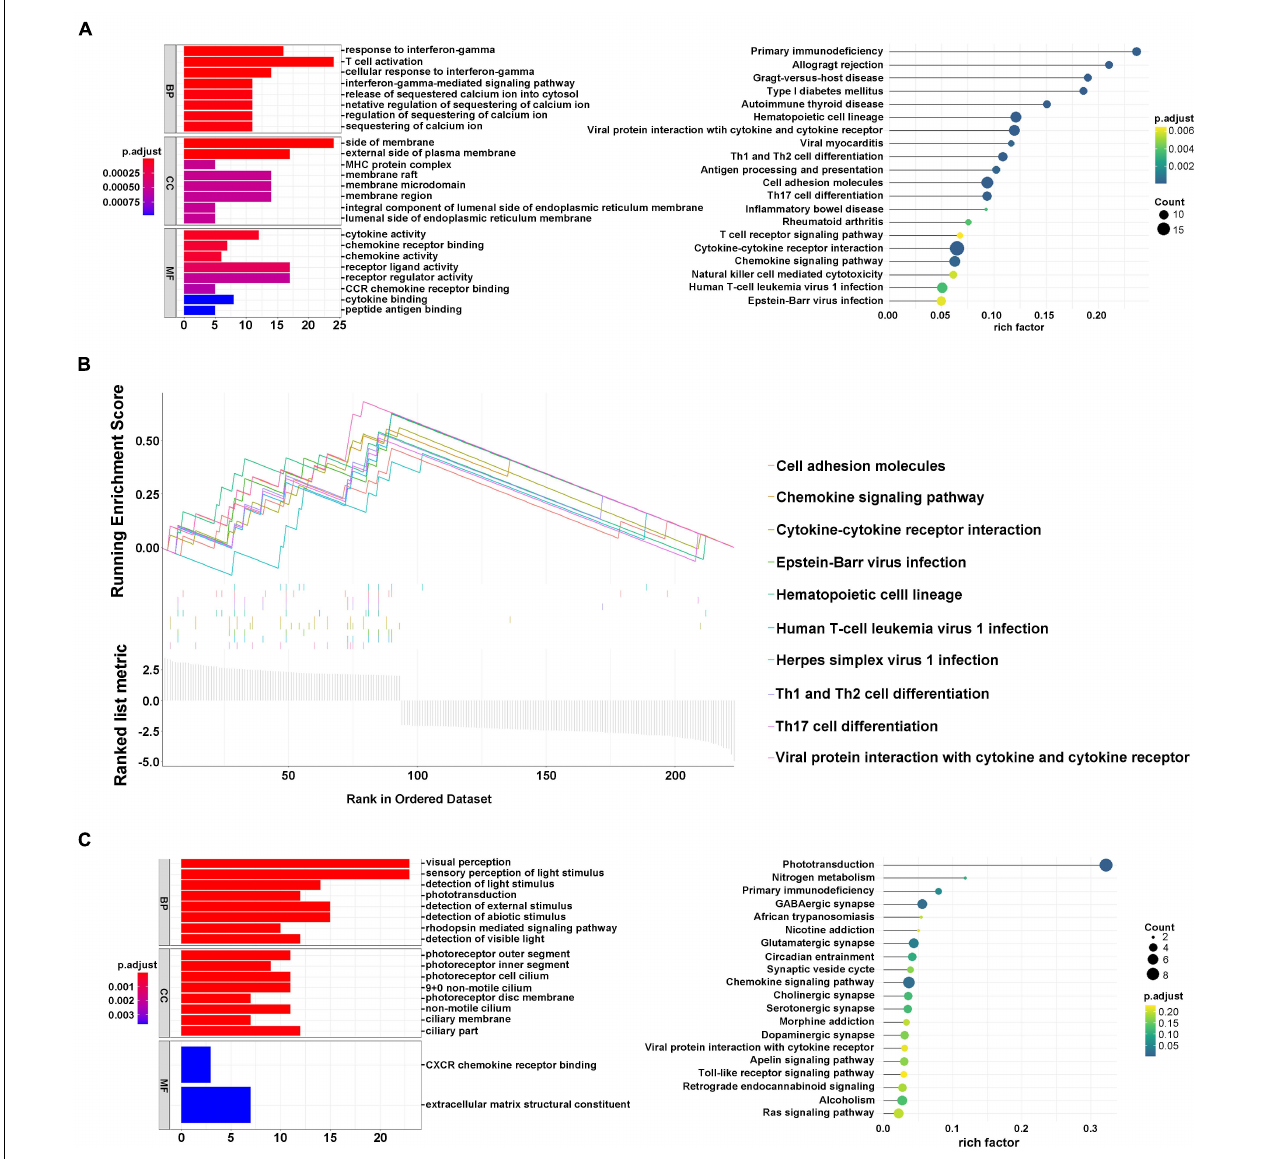
FIGURE 3 | Interaction of ferroptosis-related genes. (A) GO and KEGG analyses of DEGs in module A. (B) GSEA analysis of DEGs in module A. (C) GO and KEGG analysis of DEGs in module